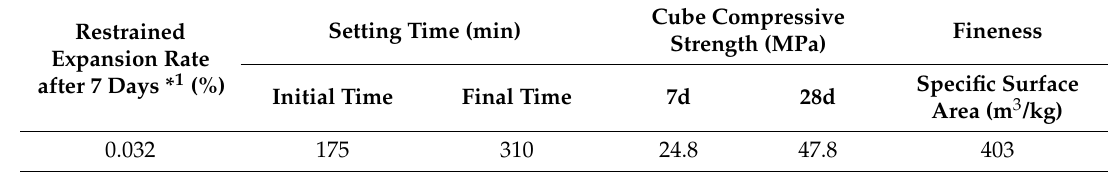
Table 6. Properties of expansive cement